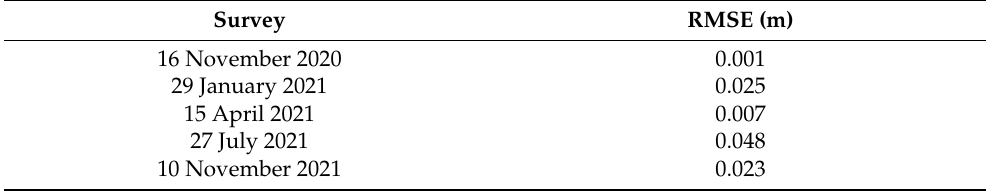
Table 3. RMSE of elevation data for each survey resulting from the validation process.